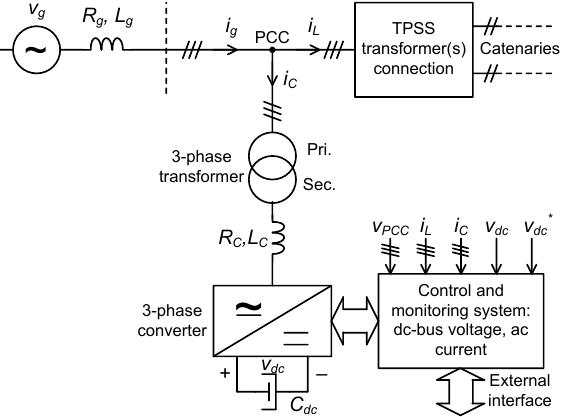
Figure 1. Electronic Balancer for compensation of the single-phase connection of a traction substation to a HV/EHV